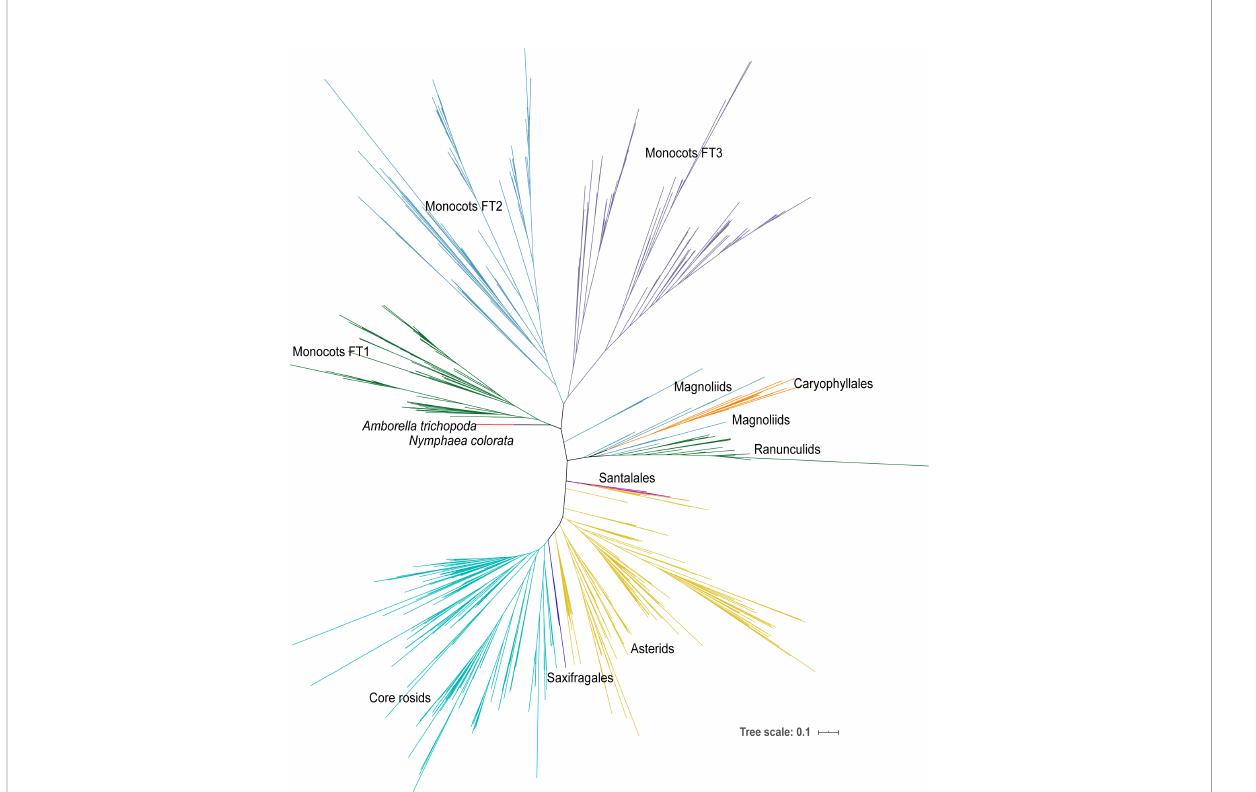
FIGURE 1 The phylogenetic tree of all FT genes in angiosperms. The phylogenetic tree was constructed using the ML method. The FT genes are from the 47-species-genome database (2 early angiosperms, 17 monocots, and 28 eudicots) and the 1KP database including early angiosperm, magnoliids, Caryophyllales, ranunculids, Santalales, Saxifragales, asterids, and core